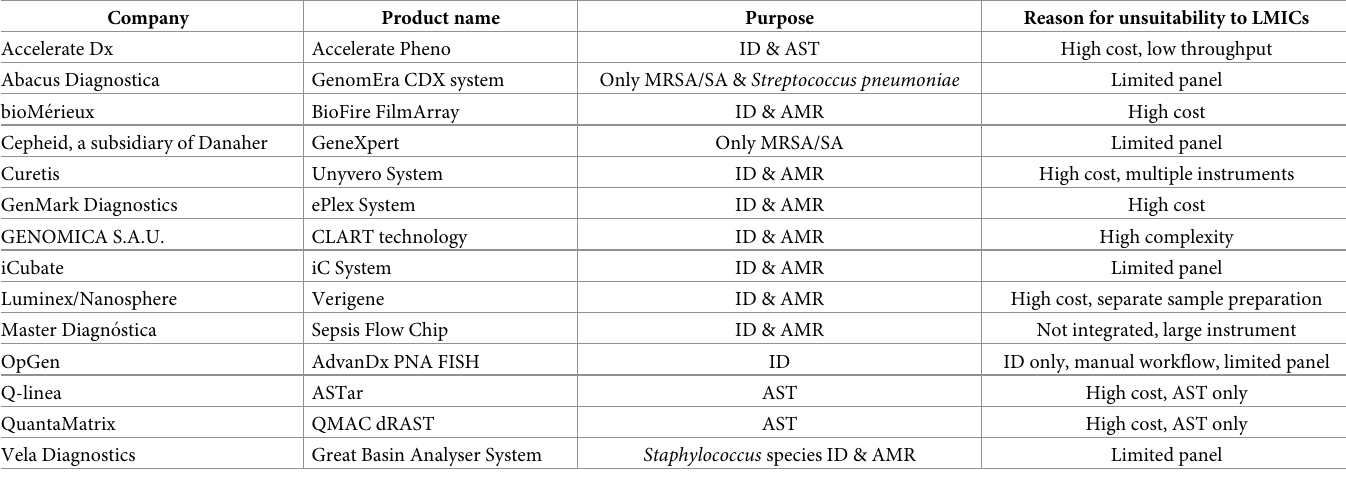
Table 1. Examples of commercially available automated platforms for identification of bloodstream infections, antimicrobial resistance, or susceptibility testing.